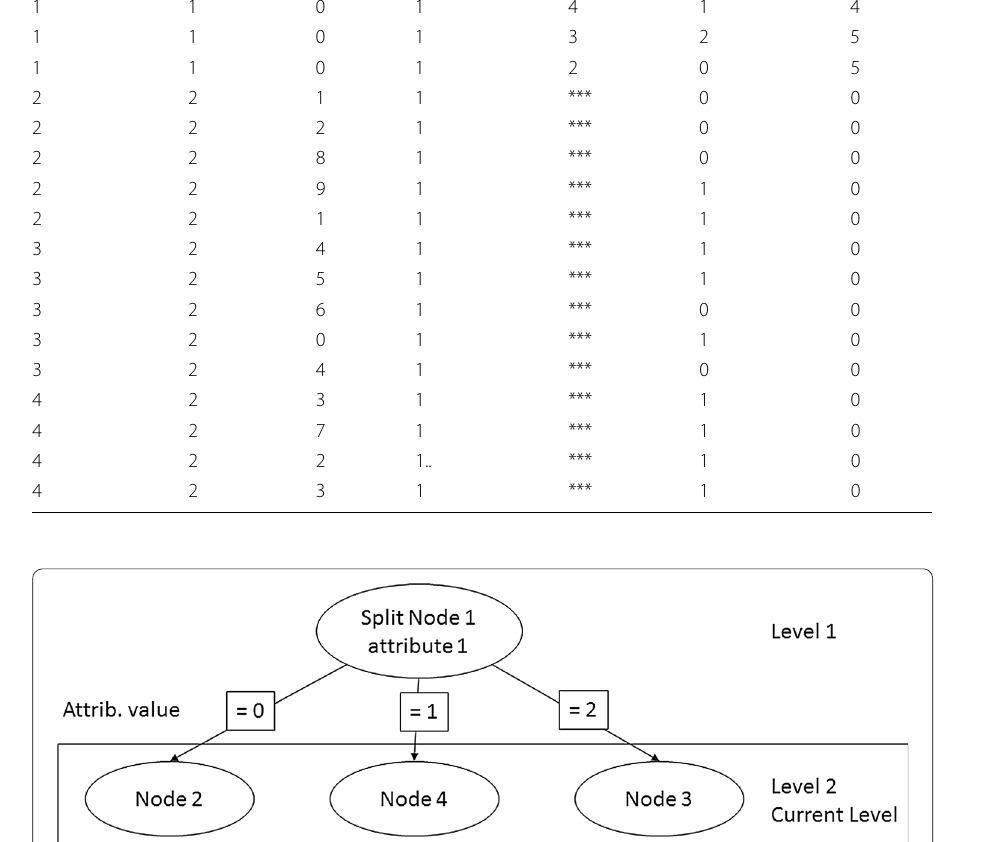
Fig. 16 Decision Tree at the beginning of iteration